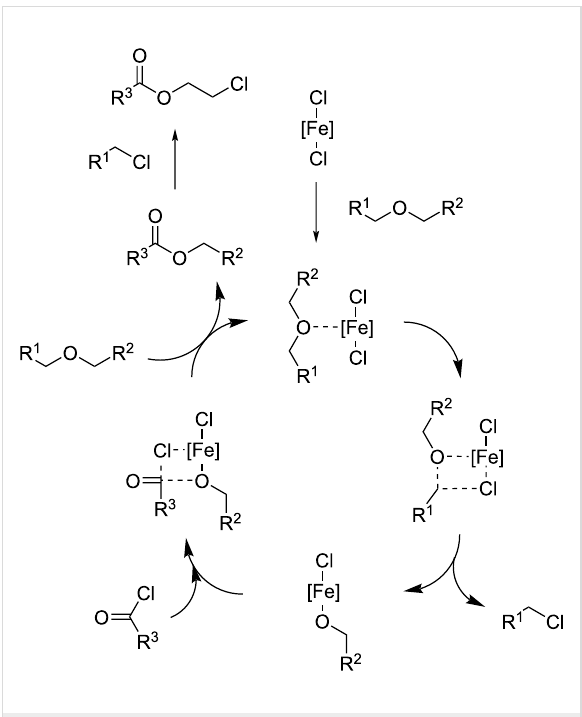
Scheme 25: Proposed mechanism for the iron-catalysed depolymeri- sation reaction of polyethers. Adapted with permission from [341], Copyright © 2012 WILEY-VCH Verlag GmbH & Co. KGaA, Weinheim. Used with permission from Stephan Enthaler and Maik Weidauer, “Low ‐ Temperature Iron ‐ Catalysed Depolymerization of Polyethers”, ChemSusChem, John Wiley and